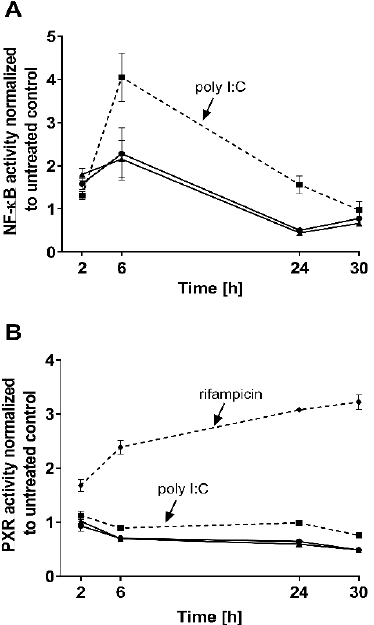
Figure 1. Impact of IFN- α 2a (1 000 U/mL, black circles; 5000 U/mL, black triangles) on activity of NF-kB ( A ) and PXR ( B ) in LS180 cells, after exposure for 2 h, 6 h, 24 h, or 30 h. Luminescence values of drug-treated samples were normalized to luminescence of untreated control samples. Data shown are the mean ± S.E.M. of three independent experiments with technical triplicates for each time point. Poly I:C (1 µ g/mL, black squares with dotted line) served as a positive control for NF-kB activation ( A ), whereas rifampicin (20 µ M, black diamonds with dotted line) was used as a positive control for PXR activation (without IFN- α 2a) ( B ). Statistical significance (see text and Table 1 for details) was evaluated using an unpaired, nonparametric, two-sided Mann–Whitney U-test comparing drug-treated samples with control samples of respective time point. Control data sets (poly I:C and rifampicin) were published before